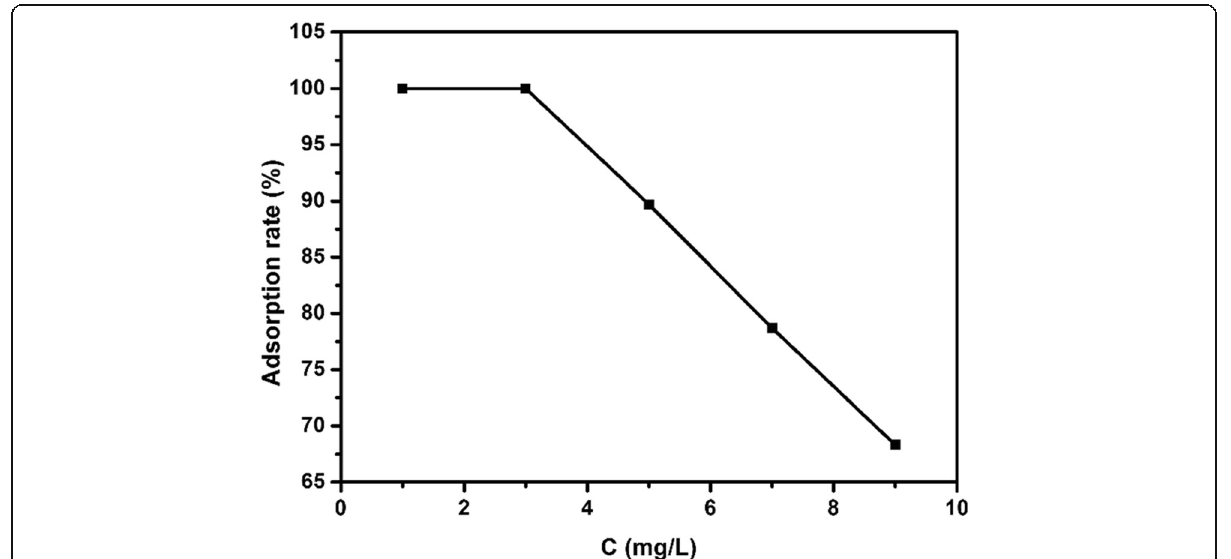
Fig. 10 Effect of initial EE2 concentration on adsorption rate